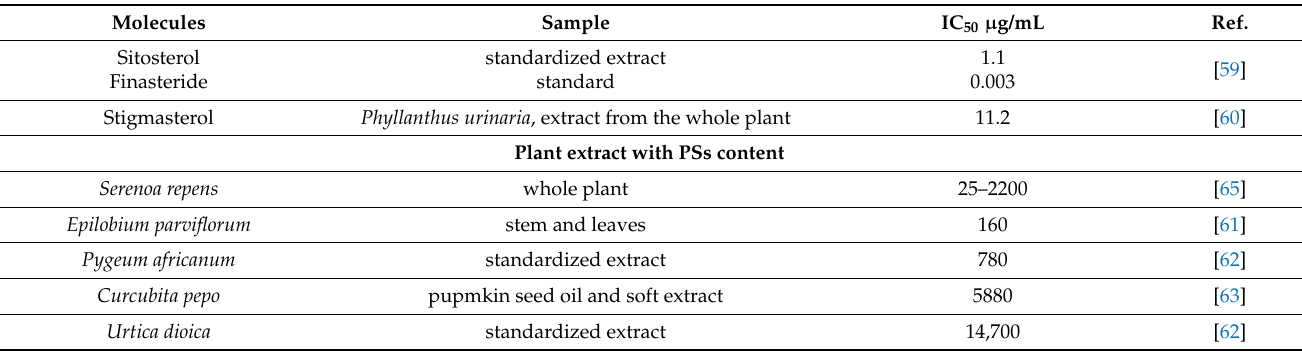
Table 1. Dietary components with 5- α R inhibitory